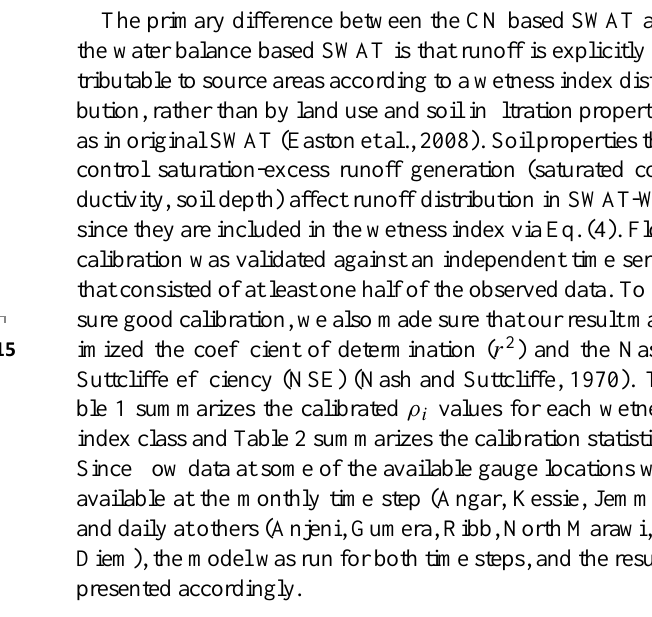
The ρ o -parameter (Eq. 4) can be constrained by the area- weighted average of ρ i , using Eq. 4 as ρ i and rearranging to solve for ρ o